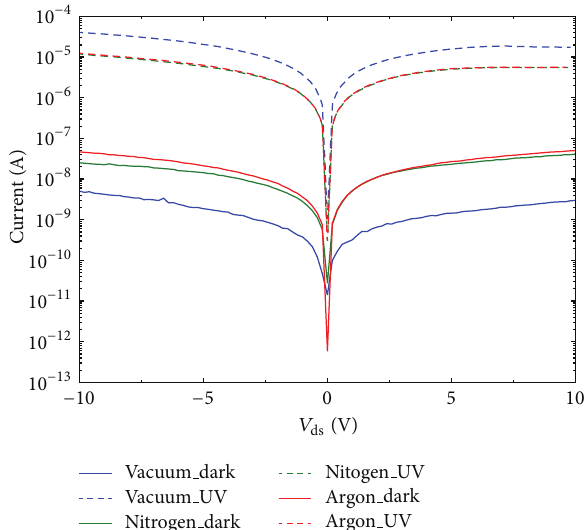
Figure 2: Current-voltage ( I - V ) characteristics of a single ZnO NW device in vacuum and two different inert gas atmospheres. The photosensitivity of the nanowires to UV excitation is clearly